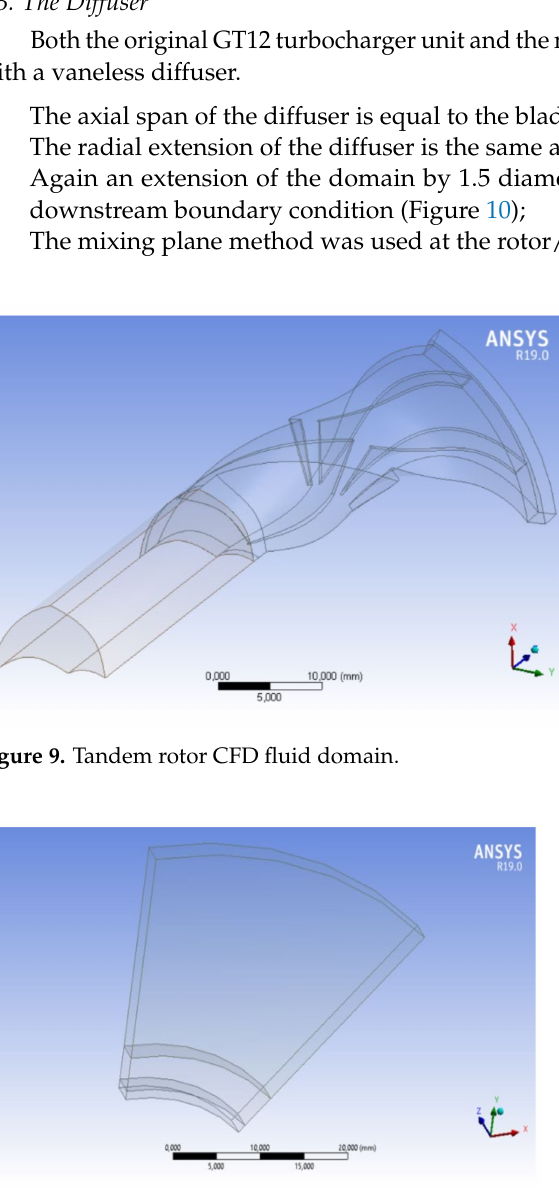
Figure 10. Diffuser CFD fluid